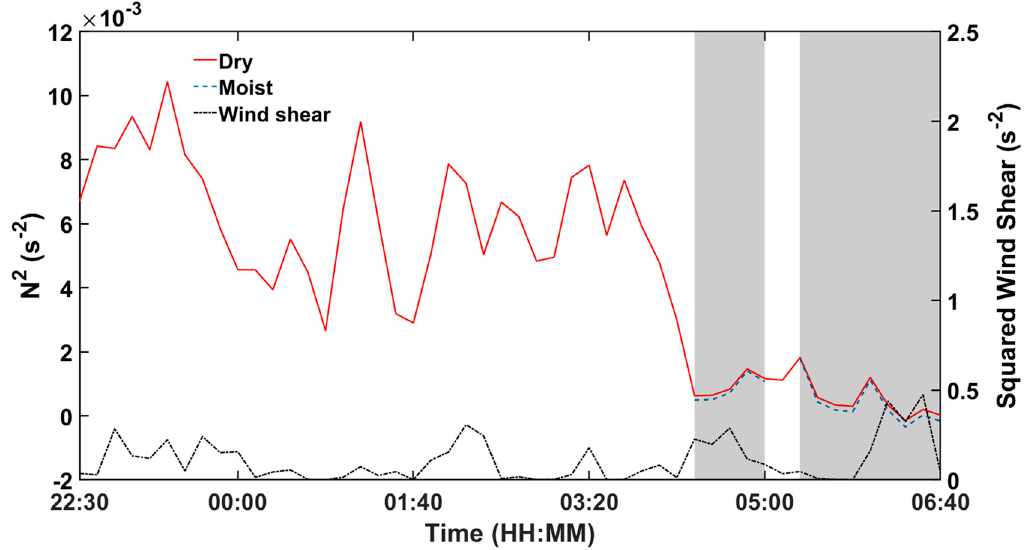
Atmosphere 2020 , 11 , x FOR PEER REVIEW Figure 5. Same as Figure 3, except for 2220 27 Oct. 2017–0640 28 Oct. 2017 in Case 6.